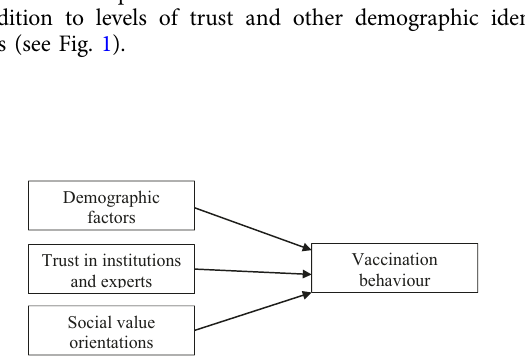
Fig. 1 Conceptual framework on determinants of vaccine behavior. It shows the relationship between theindependent and dependent variables